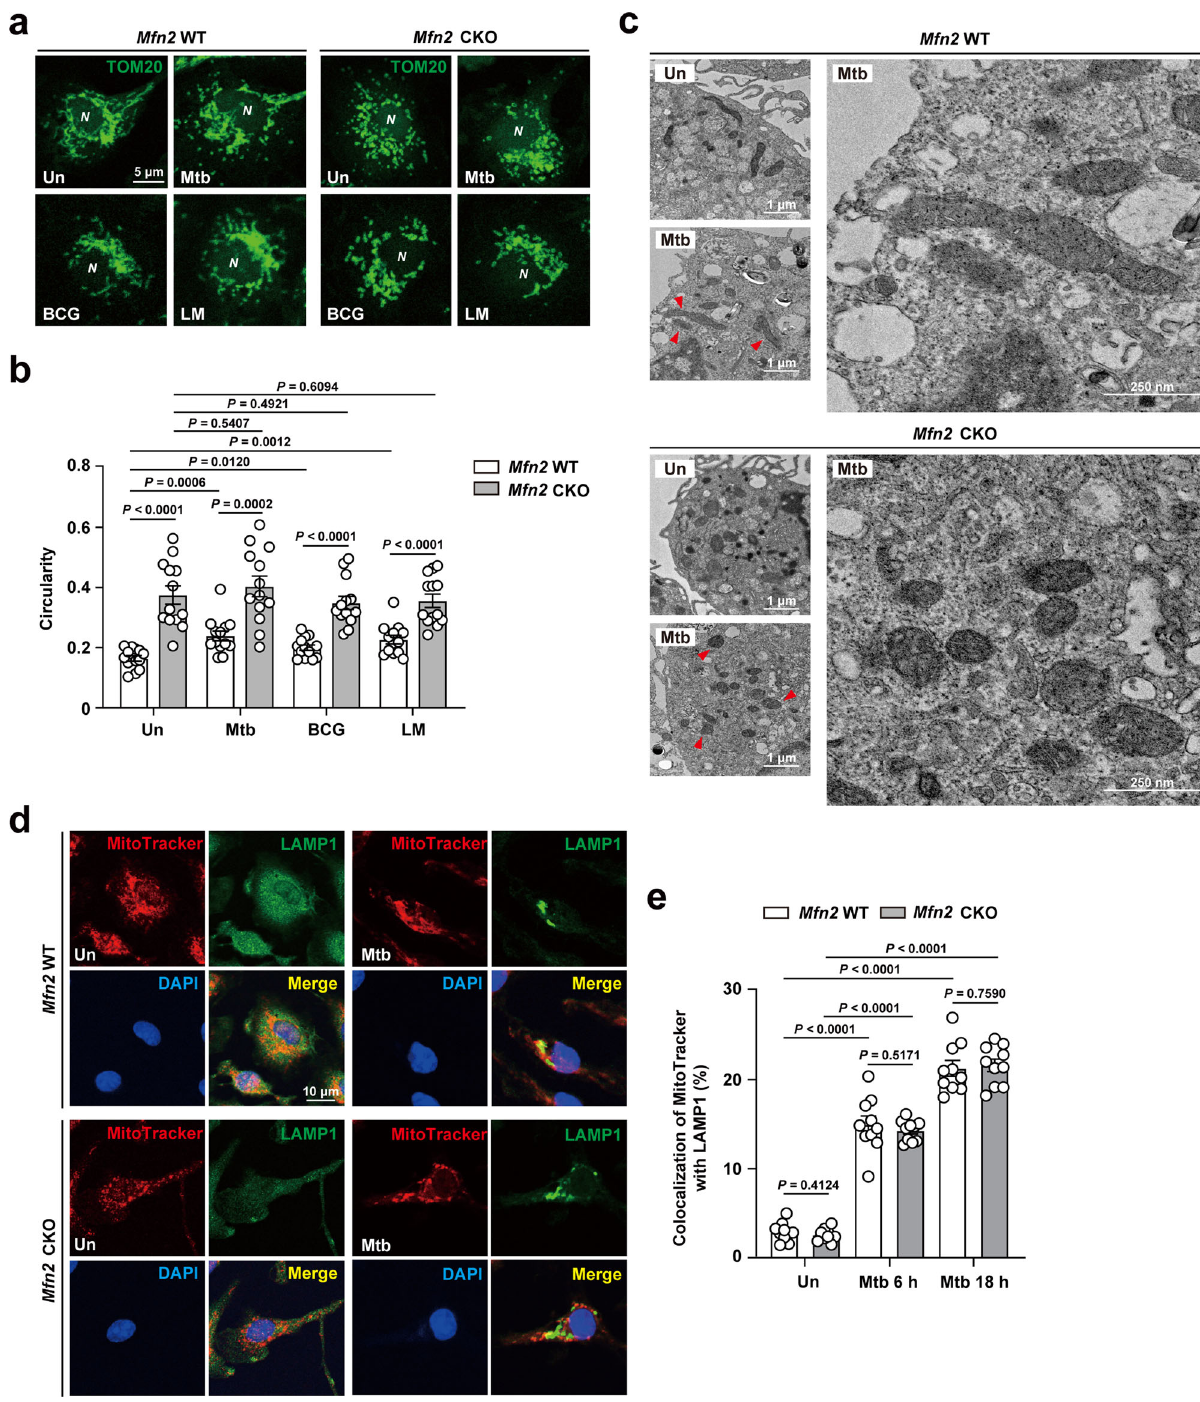
Fig. 6 MFN2 controls excessive induction of mitochondrial fragmentation, but does not impact mitophagy, in macrophages during infection. a TOM20 (green) stained BMDMs from Mfn2 WT and Mfn2 CKO infected with Mtb (MOI 5 for 18 h), BCG (MOI 5 for 18 h), or LM (MOI 5 for 6 h). Cells were visualized by confocal microscopy. Scale bars, 5 μ m. b Quanti fi cation of the mitochondrial morphology (circularity) in ( a ). c Representative electron microscopy image of Mfn2 WT and Mfn2 CKO BMDMs infected with Mtb (MOI 5) for 18 h. Scale bars, 1 μ m and 250nm. d BMDMs from Mfn2 WT or Mfn2 CKO mice were infected with Mtb (MOI 5 for 18 h) and stained with MitoTracker (red), LAMP1 (green), and DAPI (for nuclei; blue). Representative images. Scale bars, 10 μ m. e Quantitative data of co-localization of MitoTracker and LAMP1 are shown. Fifty cells in 13 fi elds were counted in each group from two different experiments. Two-tailed Student ’ s t test is used to calculate the signi fi cance ( b , e ). Data are presented as mean ± SEM and are representative of three independent experiments. Un, uninfected; N,